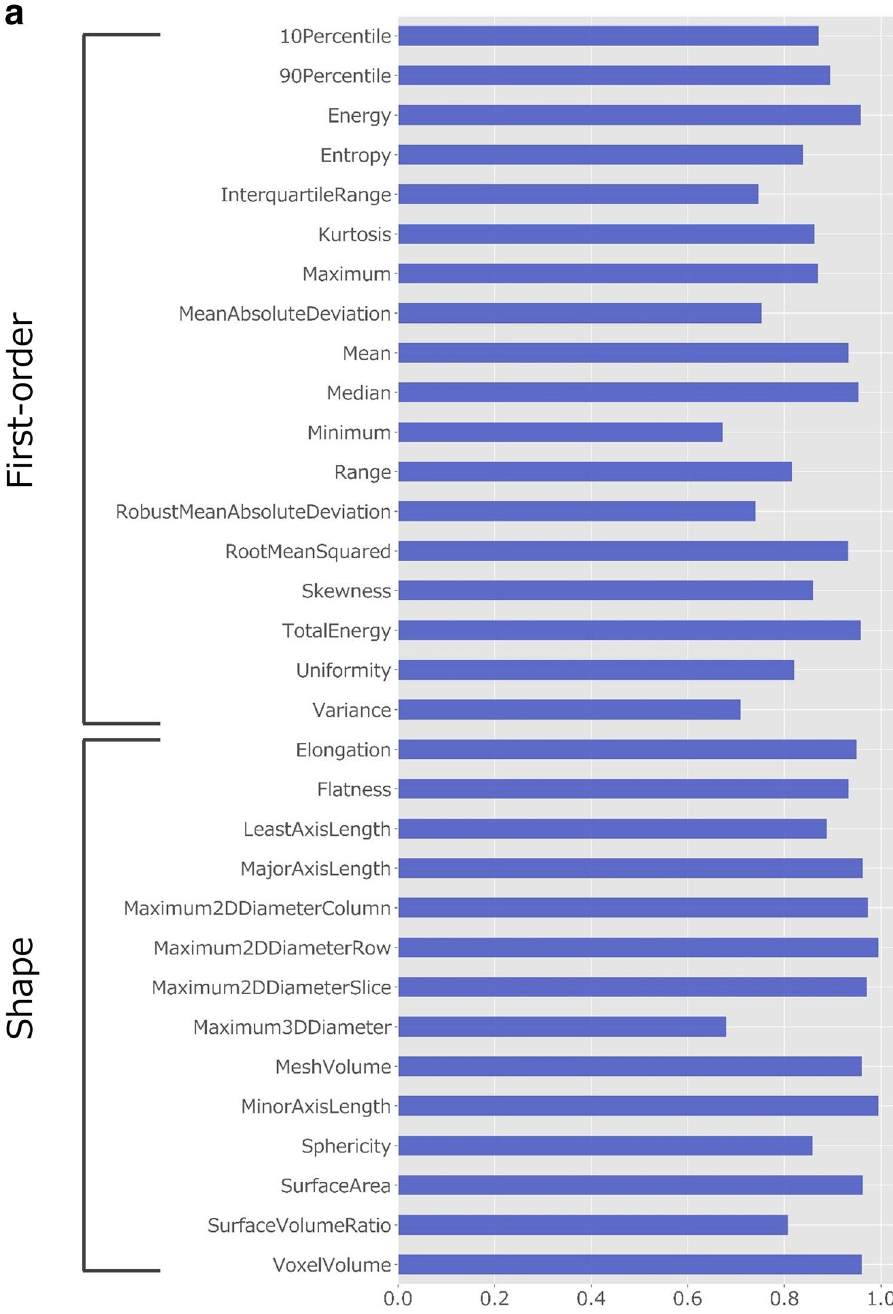
Figure 2. ICC values for radiomics features obtained by manual and automatic segmentation. ( a ) ICC values for first-order and shape-based features. ( b ) ICC values for features with high-order (GLCM, GLRLM, GLSZM, NGTDM, and GLDM-based) features. GLCM : gray-level co-occurrence matrix, GLDM : gray-level dependence matrix, GLRLM : gray-level run-length matrix, GLSZM : gray-level size zone matrix, ICC : intraclass correlation coefficient, NGTDM : neighboring gray tone difference